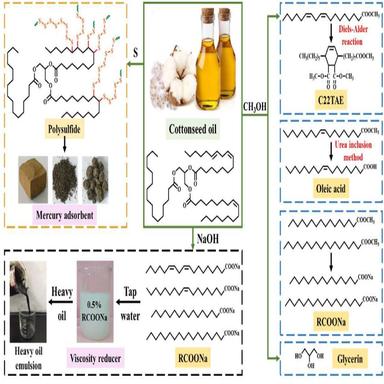
Versatility of CSO as sustainable source for advanced functional materials design. CSO, cottonseed oil.